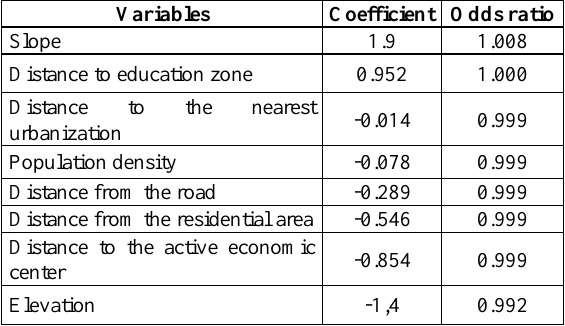
Table 6. Estimated coefficients and odds ratio for the